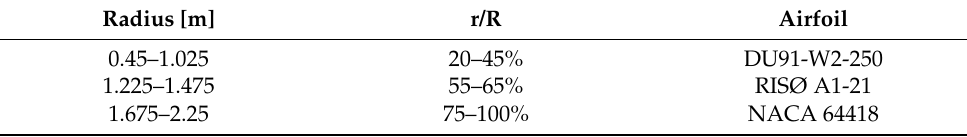
Table 1. Mexico rotor blade